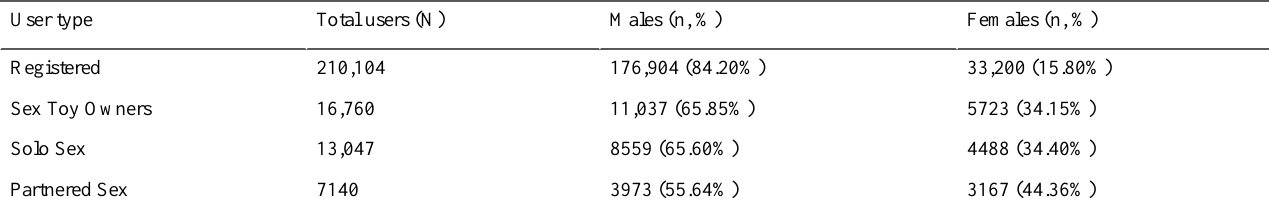
Table 1. Summary of user statistics of the